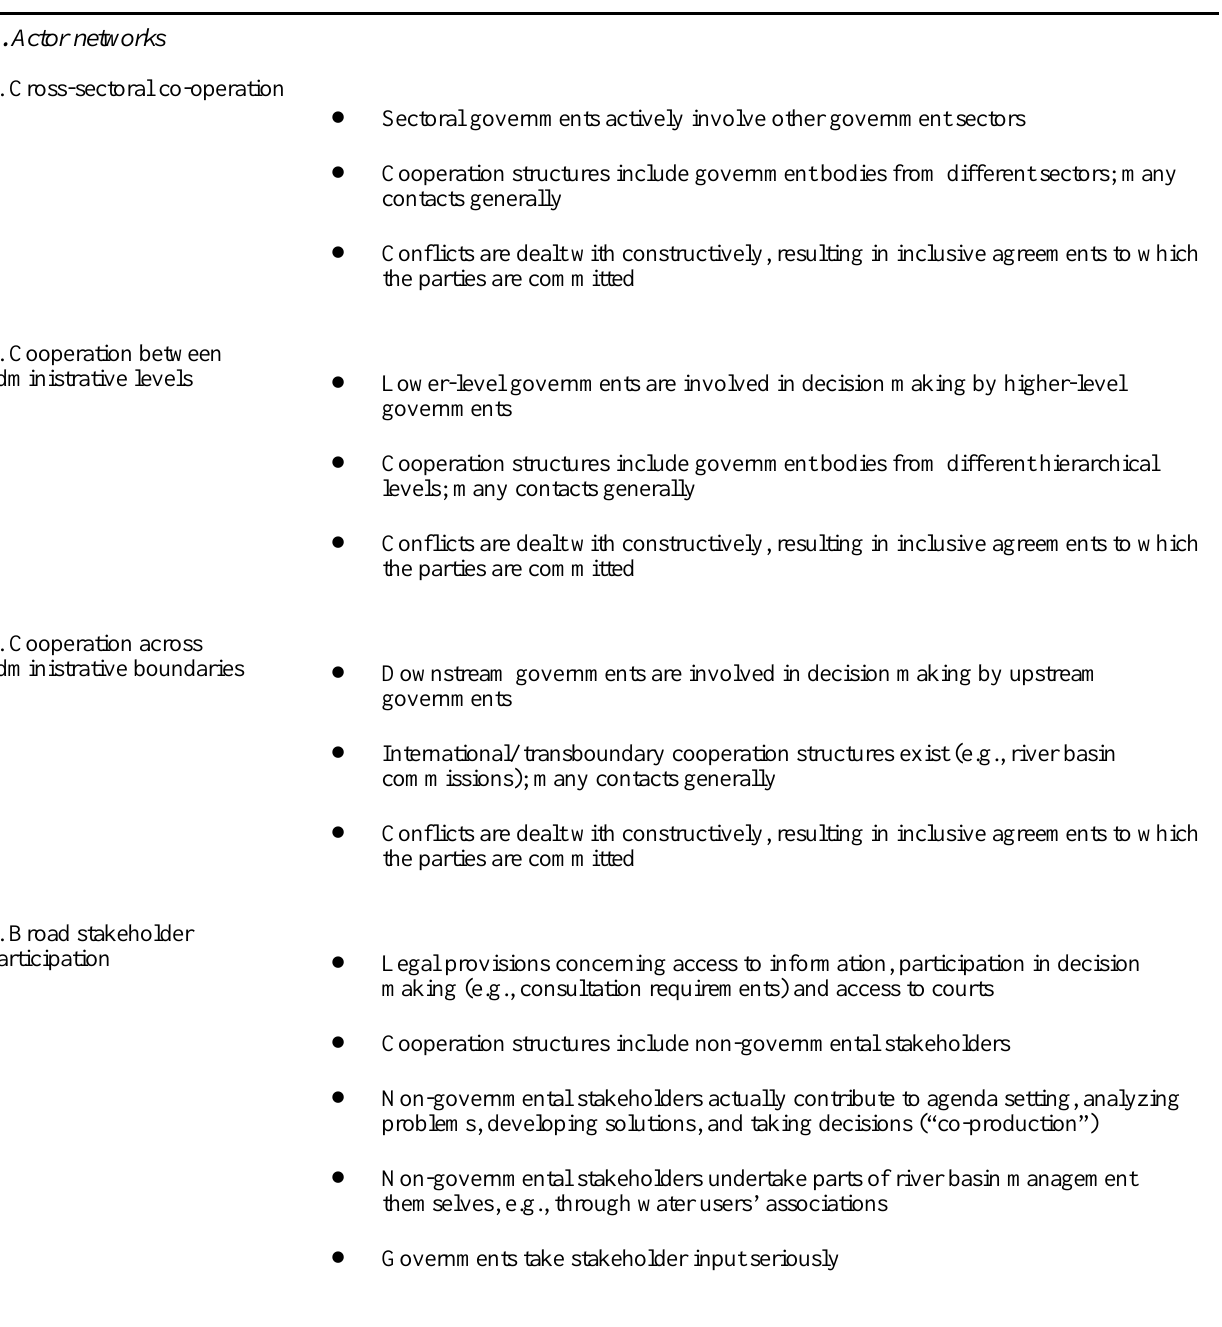
Table 1. Framework for adaptive management regimes (Raadgever and Mostert 2005)